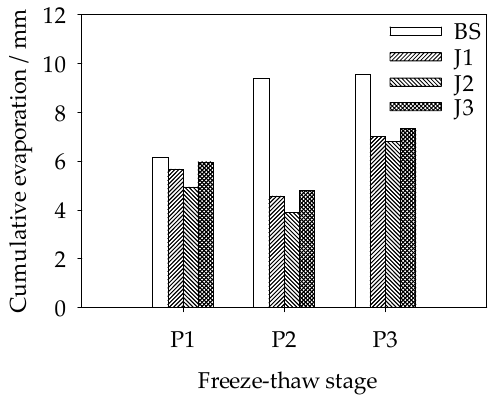
Figure 4. Soil evaporation with different straw mulch modes in three freeze–thaw stages.